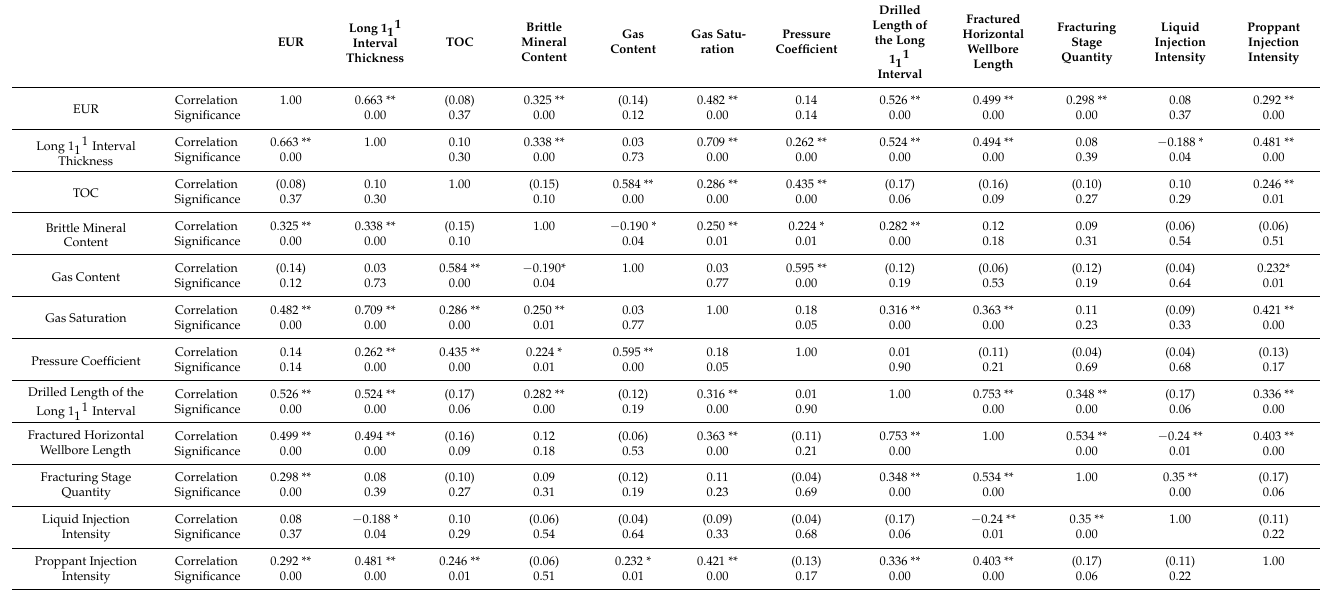
Table 2. Results of the Pearson correlation